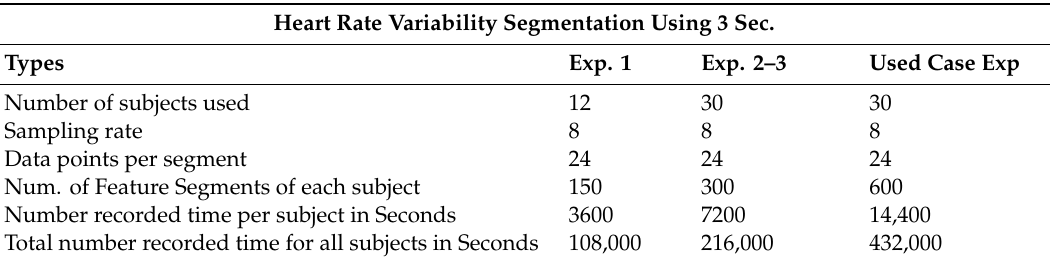
Table 1. Data segmentation for continuous data